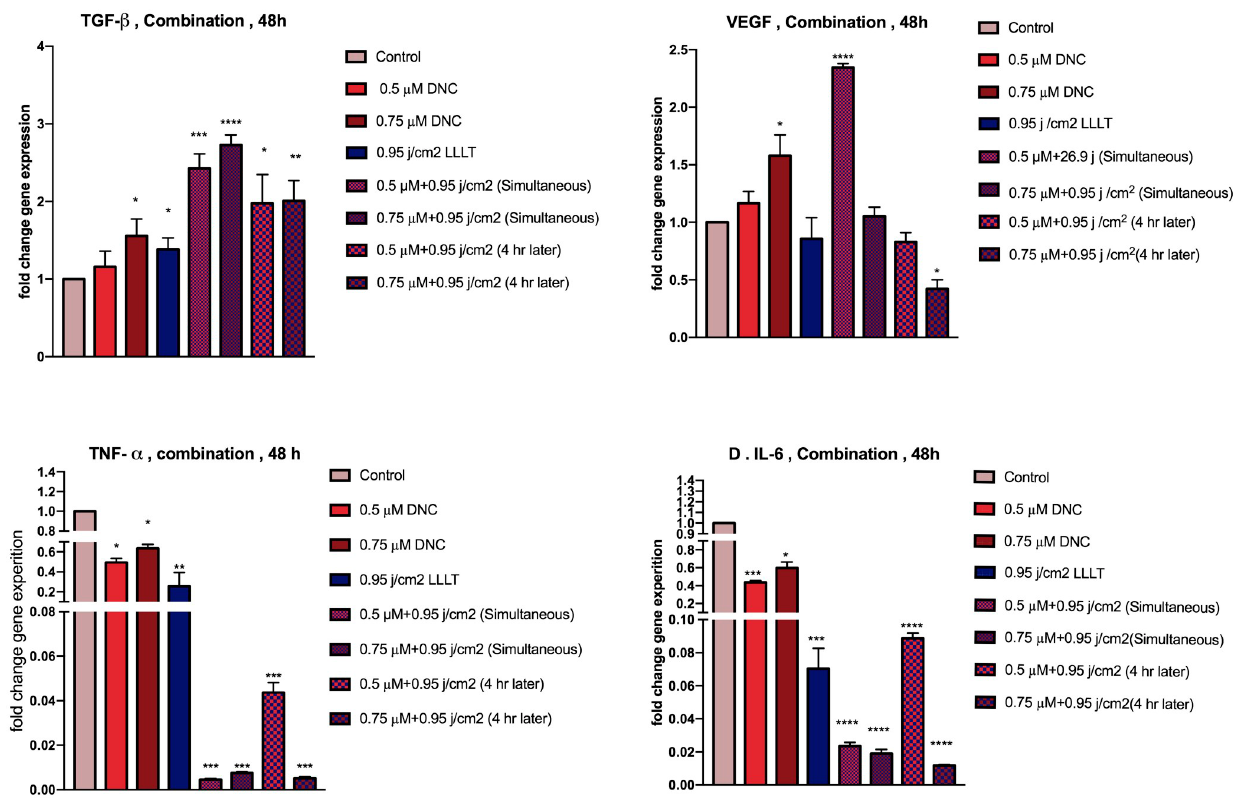
Fig 4. Gene expression in MEFs under 48h treatment with DNC (0.5, 0.75 μ M) and LLLT 450 nm (0.95 j/cm 2 ) alone and in combination. (A&B) Represent a significant increase in TGF- β and VEGF transcripts and (C&D) represent a significant decline in TNF- α and IL-6 expression after treatment with DNC+LLLT simultaneously and with 4h time intervals similarly. Data are presented as mean ± SEM; n = 3 ( � : P < 0.05, �� : P < 0.01, ��� : P < 0.001, ���� : P < 0.0001).